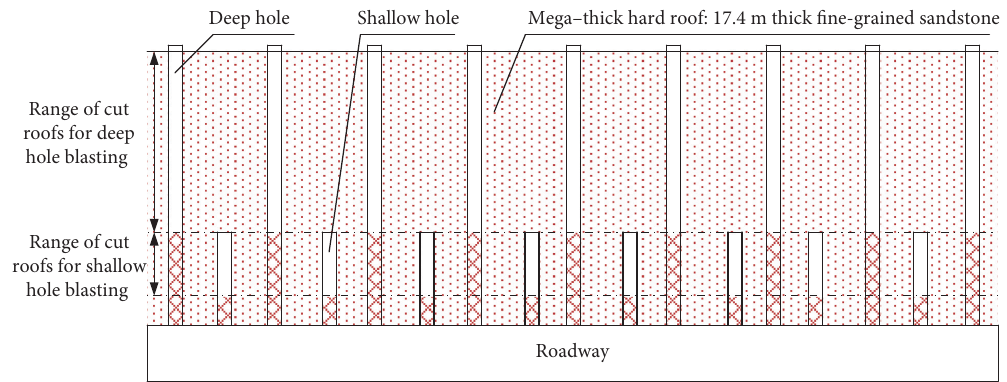
Figure 6: Deep-shallow hole blasting